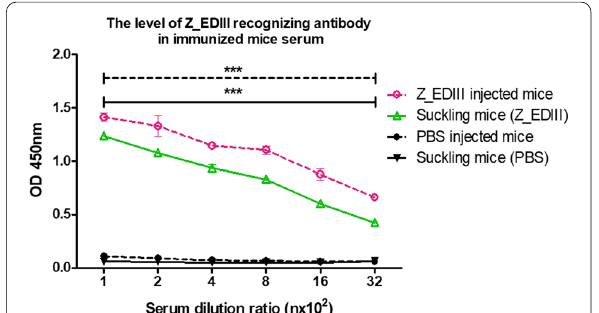
Fig. 6 The level of Z‑EDIII specific antibody after immunization. C57BL/6 mice ( n 5 per group) were immunized with Z_EDIII or PBS = at 0, 14, and 42 dpi. Immunized mice were mated with homozygous breeding pairs. To measure Z_EDIII‑specific IgG antibodies, blood samples were collected at day 2. Serum samples were serially diluted from 1:100 to 1:3,200 and the antibody level was determined by ELISA. Data show the mean SD of five mice per group. Each sample ± was assayed in duplicate. Statistical analysis * p < 0.05, ** p < 0.01, *** p < 0.001